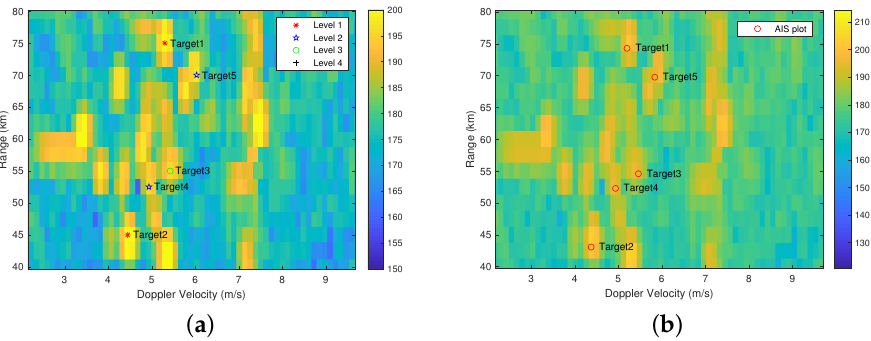
Figure 8. The plots of five selected moving vessels on an R-D map. ( a ) Plots detected by the radar. ( b ) Corresponding AIS plots.